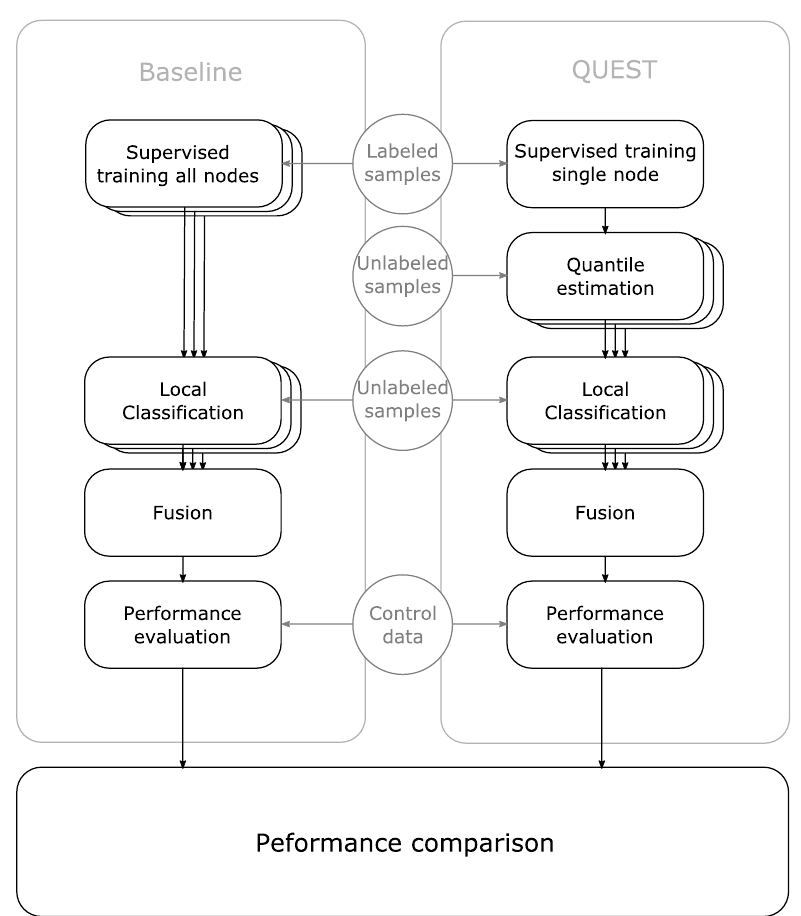
Figure 5. Block diagram of the procedure to compare the performance of QUEST to complete supervised learning. The QUEST classifiers are based on supervised training of a single